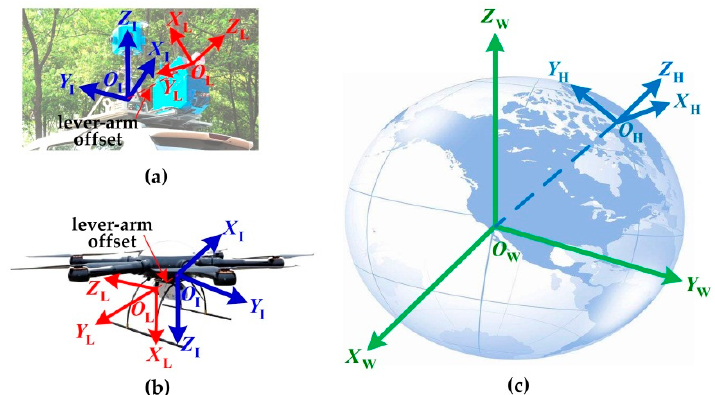
Figure 3. Coordinate frames of the MLS and ULS systems. ( a , b ) the laser scanner frame O L - X L Y L Z L and IMU frame O I - X I Y I Z I . ( c ) the local level frame O H - X H Y H Z H and WGS84 earth centered earth fixed frame (ECEF) frame O W - X W Y W Z W .